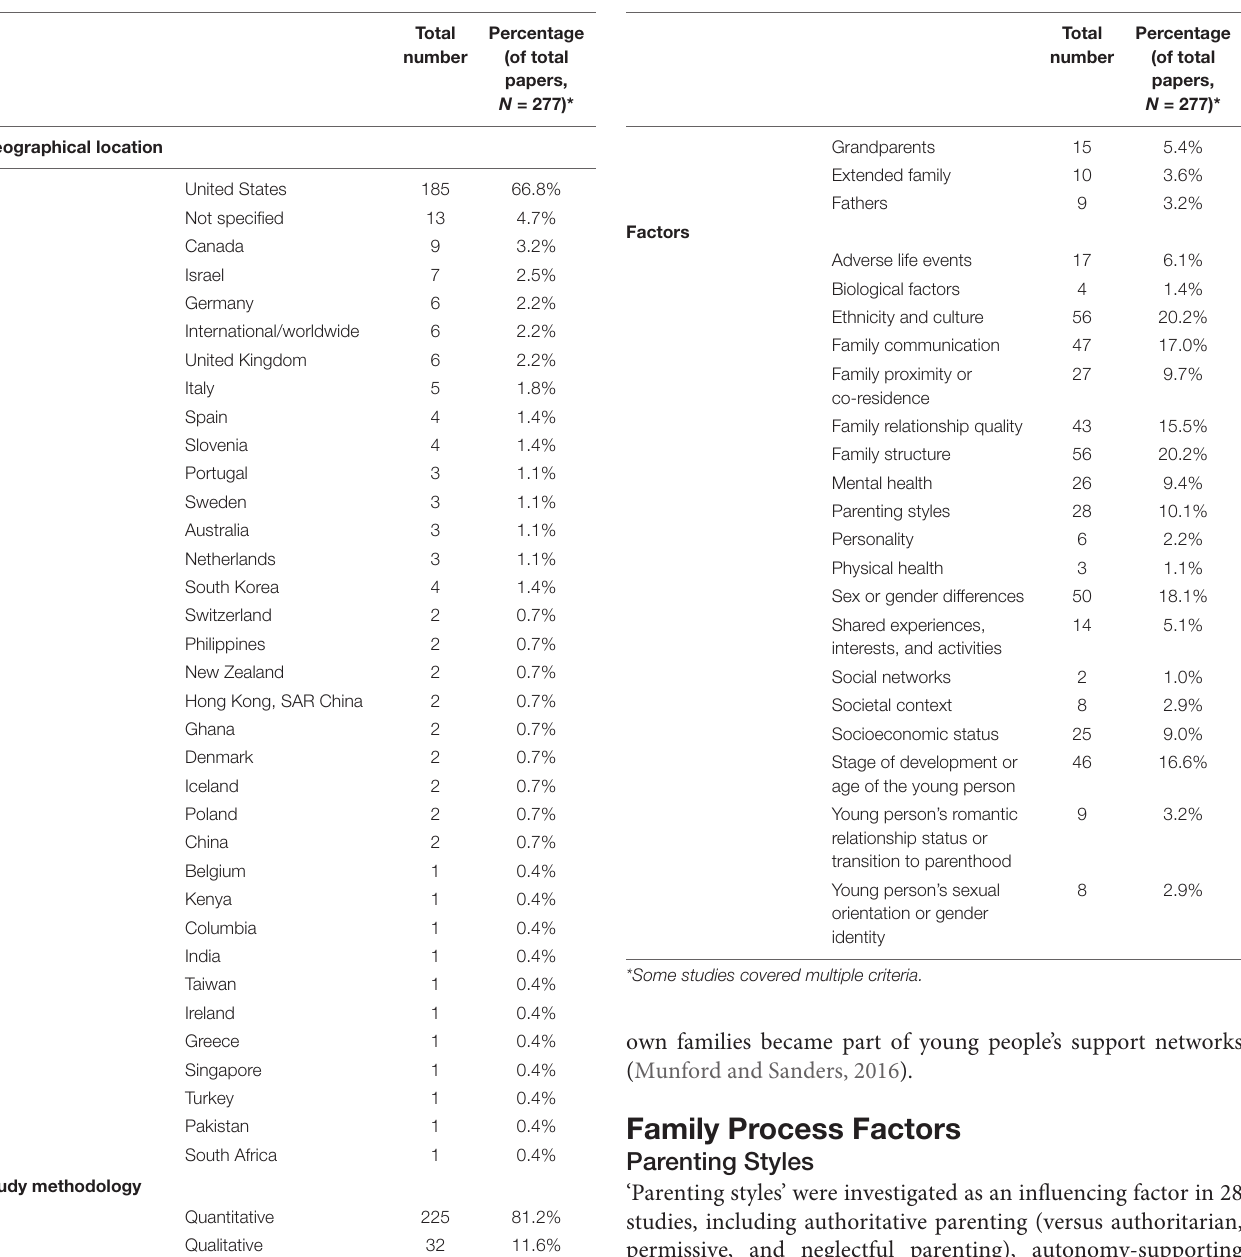
TABLE 1 | Summary information about the 277 identified